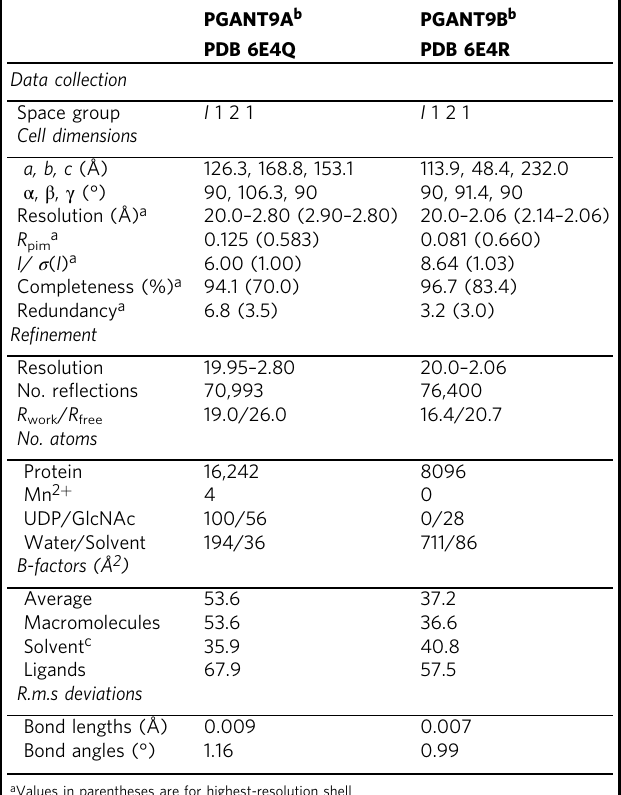
a Values in parentheses are for highest-resolution shell b Data from a single crystal were used for solving the structure c Water, (poly)ethylene glycol, and